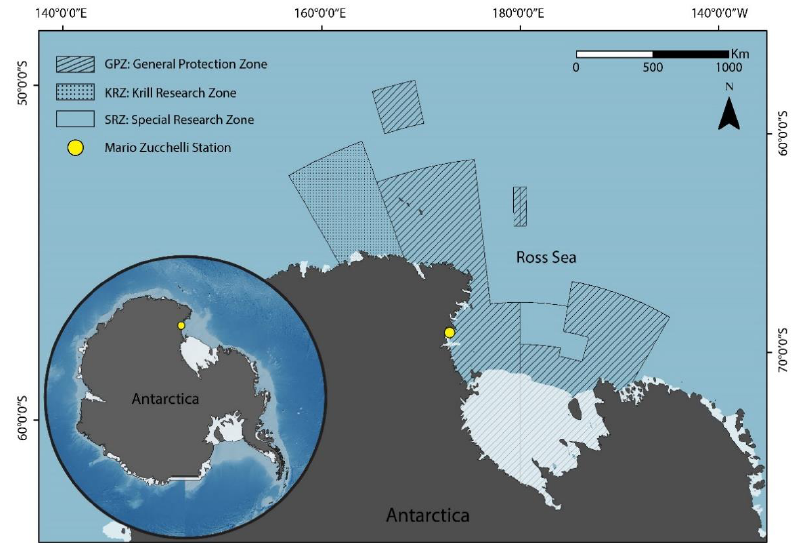
Figure 1. The Ross Sea region Marine Protected Area (RSRMPA). Map of the RSRMPA established in 2017. The Marine Protected Area is composed by (i) the General Protection Zone (GPZ), a fully protected area where no fishing is permitted; (ii) a Special Research Zone (SRZ), where the research fishing for krill and toothfish is limited; a (iii) Krill Research Zone (KRZ), with controlled research fishing for krill. Zone (GPZ) of the RSRMPA (Figure 1). There, the Italian summer station “Mario Zuc- between the tongues of the Campbell and Drygalski glaciers (74°42′ S, 164°07′ E, Figures 1 and 2).